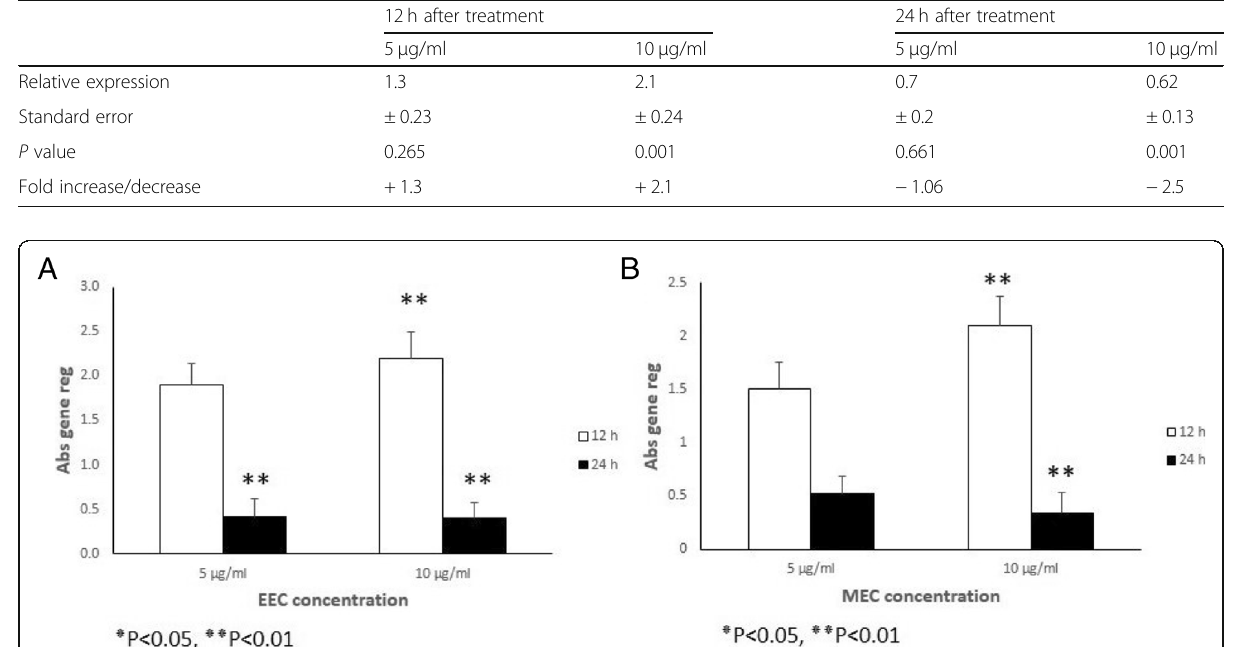
Table 4 The total expression ratio of the gene of TGF β 1 in the MEFs treated with various concentrations of methanol extract of Calendula (5 and 10 μ g/ml) relative to control group is presented in each time (12 and 24 h after treatment). The statistic test for significance is randomization re-allocation test, implemented in the relative expression software tool. Significant down or upregulations of the genes highlighted